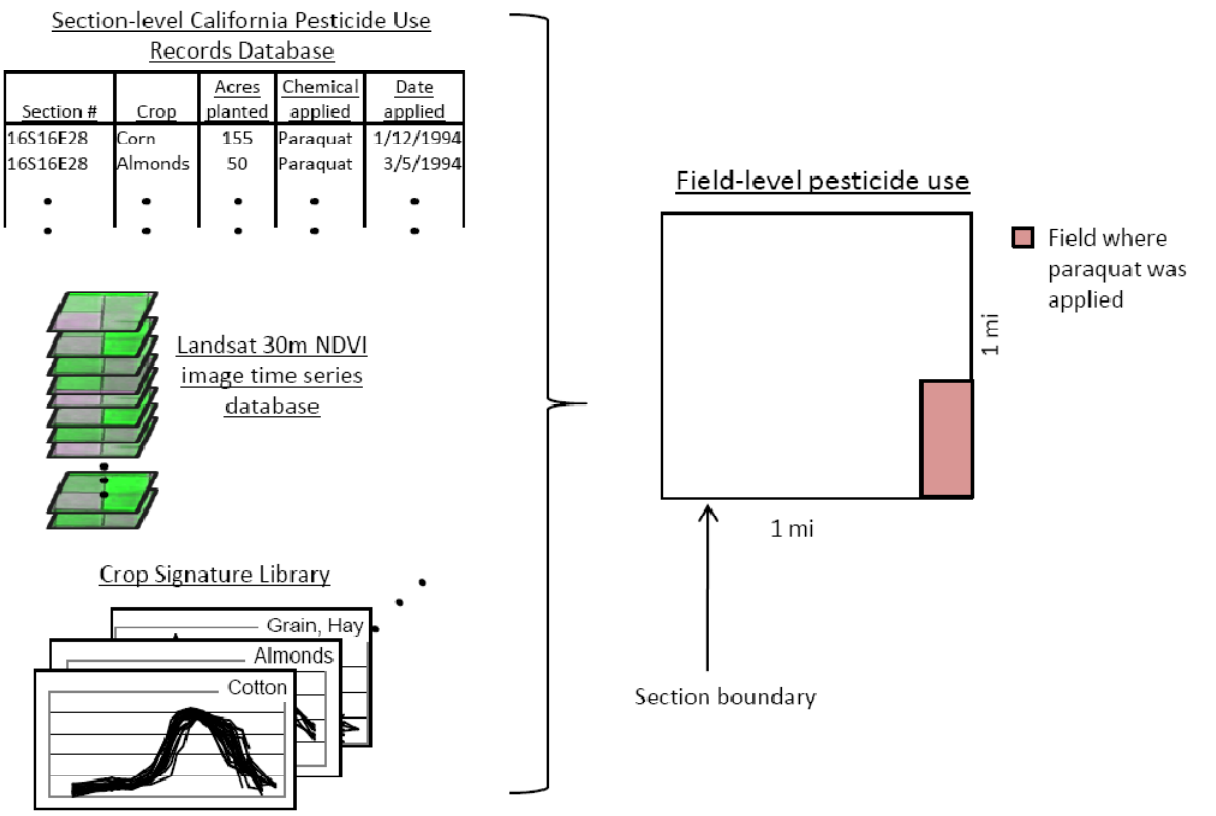
Figure 2. System diagram for integrating Landsat image time series,